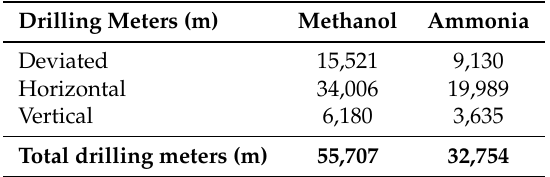
Table 6. Drilling meters in the offshore methanol and ammonia production scenarios.